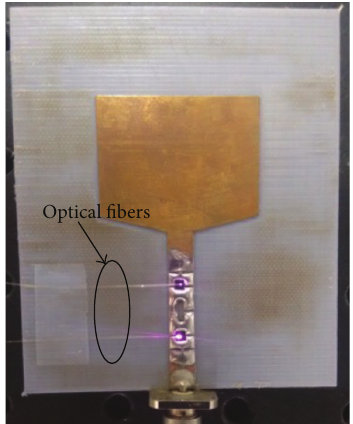
Figure 12: Optically controlled reconfigurable filtenna operating in the 2.4 GHz band (photoconductive switches on “ON-state”): real incident light can be observed into the two photoconductive